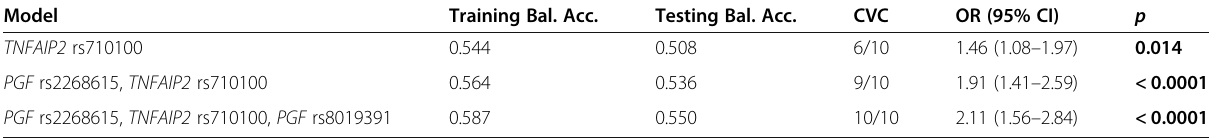
Table 5 SNP – SNP interaction models of the PGF and TNFAIP2 genes analyzed by the MDR method Model Training Bal. Acc. Testing Bal.